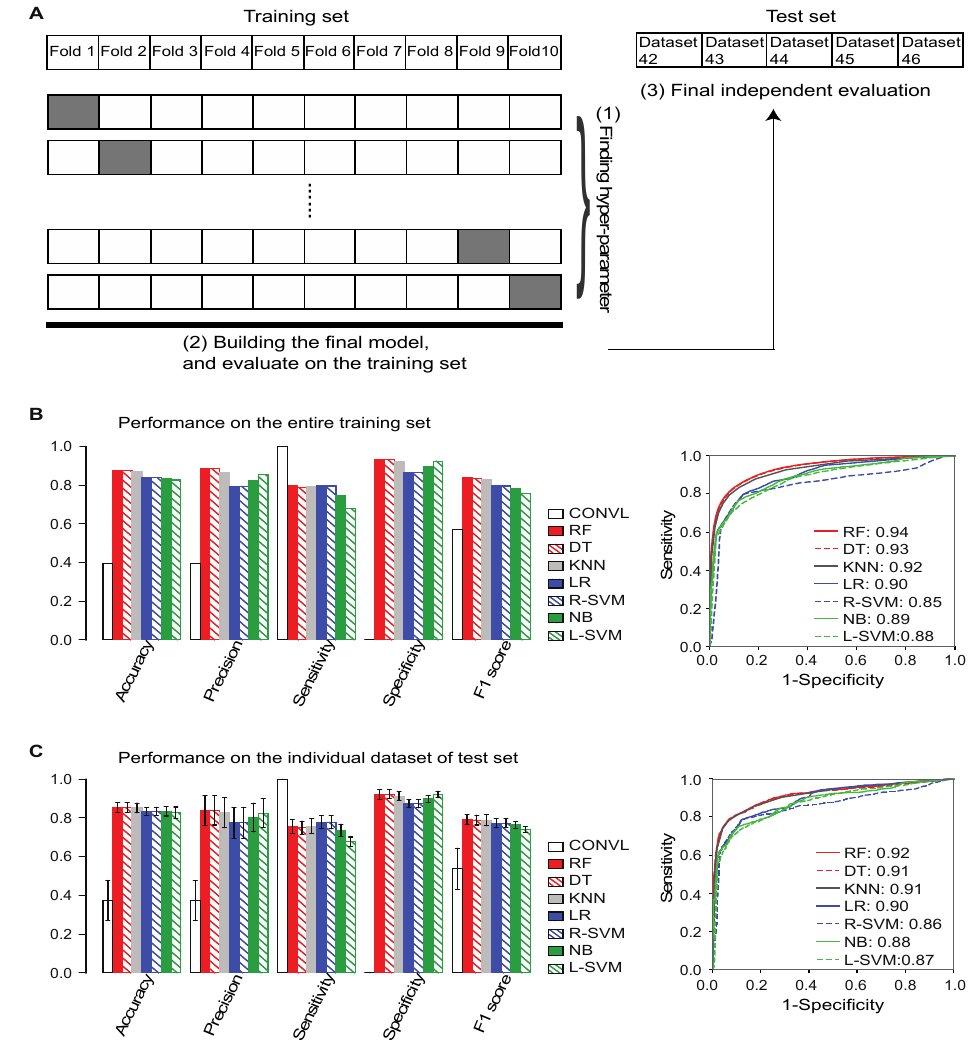
Figure 3. ML model construction and evaluation. ( A ) The overall architecture of Flnc training and testing. The best hyperparameters, specifically the hyperparameters yielding the best mean F1 score, were chosen using the 10-fold cross-validation approach as follows. The training set was randomly split into 10 even folds, 9 of which were used in training the models. The 10th fold was used for validation. We repeated this process holding each individual fold out and training with the other 9 folds. From this, we derived 10 models for each hyperparameter setting. For each of the 10 models, we calculated the mean F1 score for each hyperparameter setting. After selecting the best hyperparameter setting, the final model was built using the entire training set and we examined the performance of the final model on the entire training set. Finally, we evaluated the performance of the final model on the test set, which was composed of the five independent datasets generated in 2019 and 2020 (Datasets 42–46). ( B ) The seven final models of Flnc outperformed the conventional method (without models) on the entire training set, and ( C ) on the five individual datasets of test set. The left bar graphs of ( B , C ) show the performance metrics accuracy, precision, sensitivity, specificity and F1 score. The right graphs ( B , C ) show the ROC curve for each model. The AUROC score is shown next to each ML model. The ROC curve of ( C ) is the ROC curve of the seven models on the Dataset 46. Please see Supplementary Figure S3B for the ROC curves of the four additional test datasets (Dataset 42–25). The seven models are ranked by the F1 score from largest to smallest. Abbreviations: CONVL, conventional approach; RF, random forest; DT, decision tree; R-SVM, RBF support vector machine; L-SVM, linear support vector machine; LR: linear regression; NB, naïve Bayes; KNN, and k-nearest neighbors.